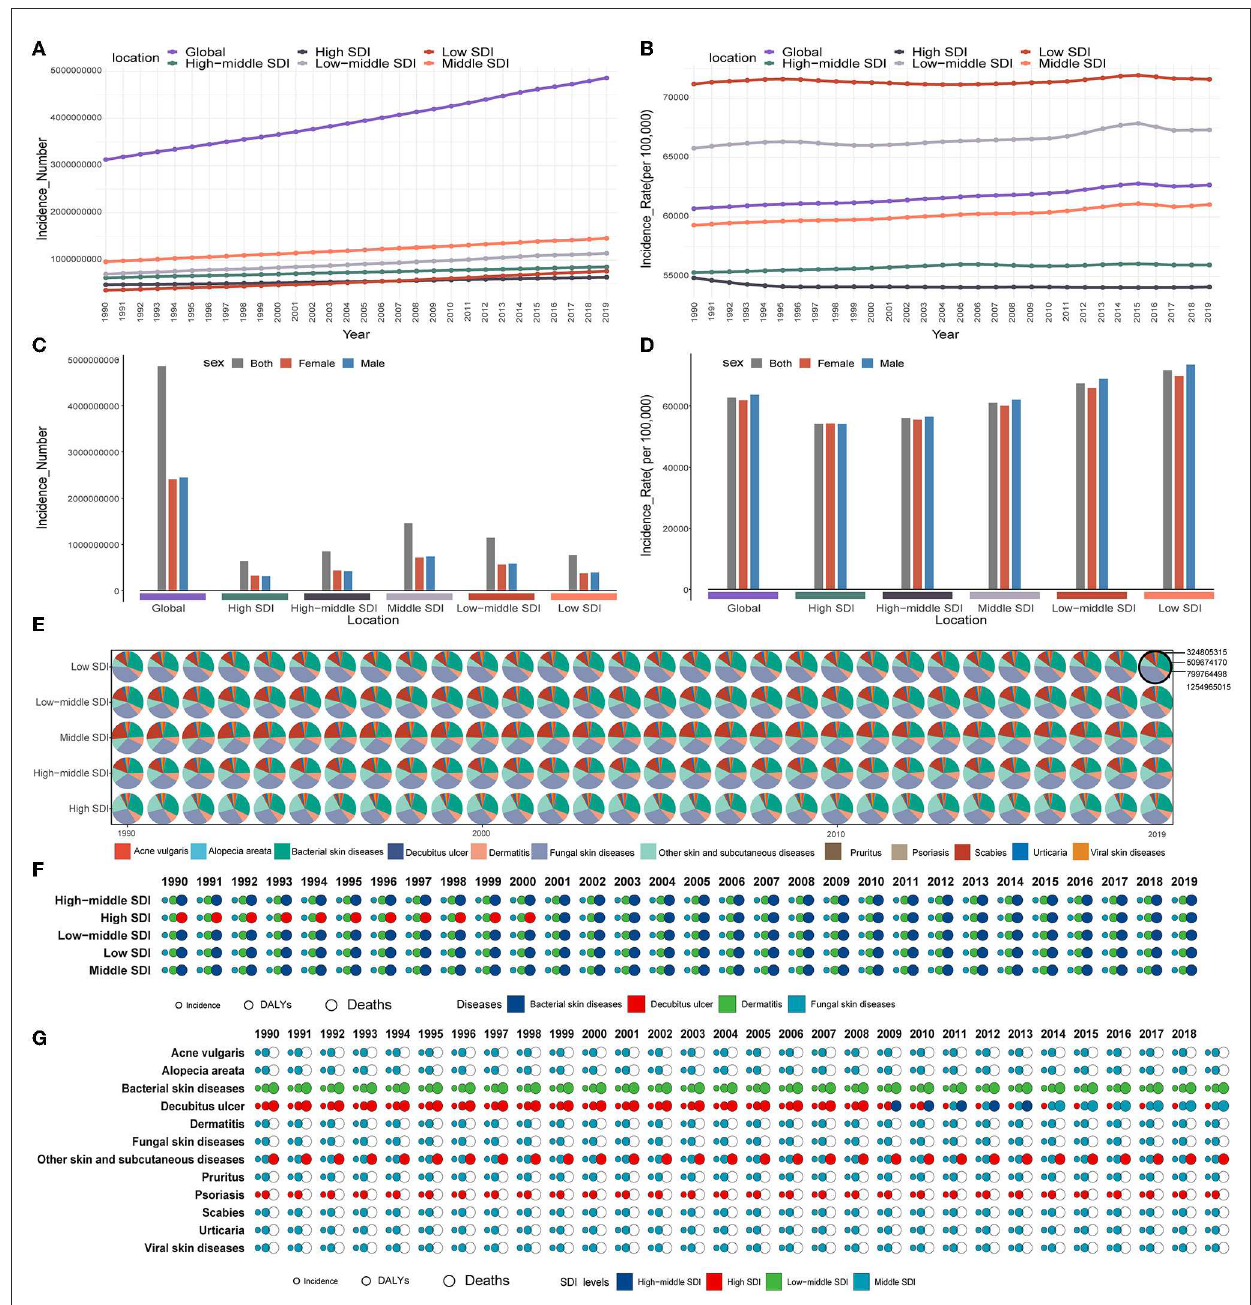
FIGURE3 Skin and subcutaneous diseases burden among different social–economic states. (A) Changing trend in each skin and subcutaneous disease new cases by global and SDI levels from 1990 to 2019. (B) Changing trend in each skin and subcutaneous disease ASIR by global and SDI levels from 1990 to 2019. (C) Skin and subcutaneous diseases new cases distribution by sex at different SDI levels in 2019. (D) Skin and subcutaneous diseases ASIR distribution by sex at different SDI levels in 2019. (E) The proportion of new cases of each skin and subcutaneous disease at different SDI levels from 1990 to 2019. (F) Type of skin and subcutaneous diseases that contribute the highest new cases, DALYs, and deaths at different SDI levels from 1990 to 2019. (G) SDI levels recorded the highest new cases, DALYs, and deaths of each skin and subcutaneous disease from 1990 to 2019. ASIR, age-standardized incidence rate; DALYs, disability-adjusted life years; SDI, sociodemographic